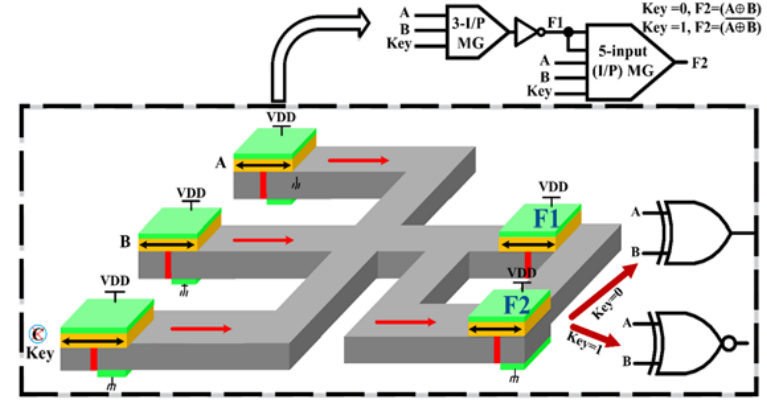
Figure 40. ASL XOR and XNOR polymorphic gates.